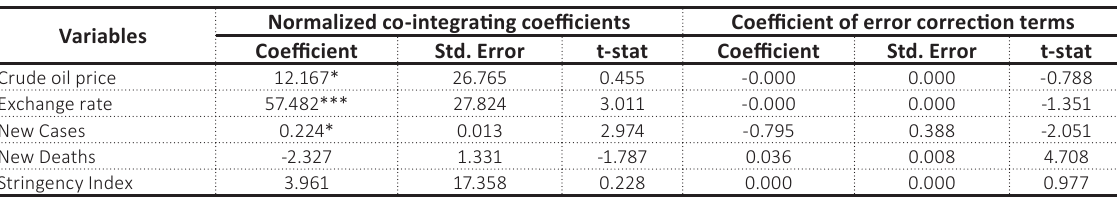
Table 4. Vector error correction model